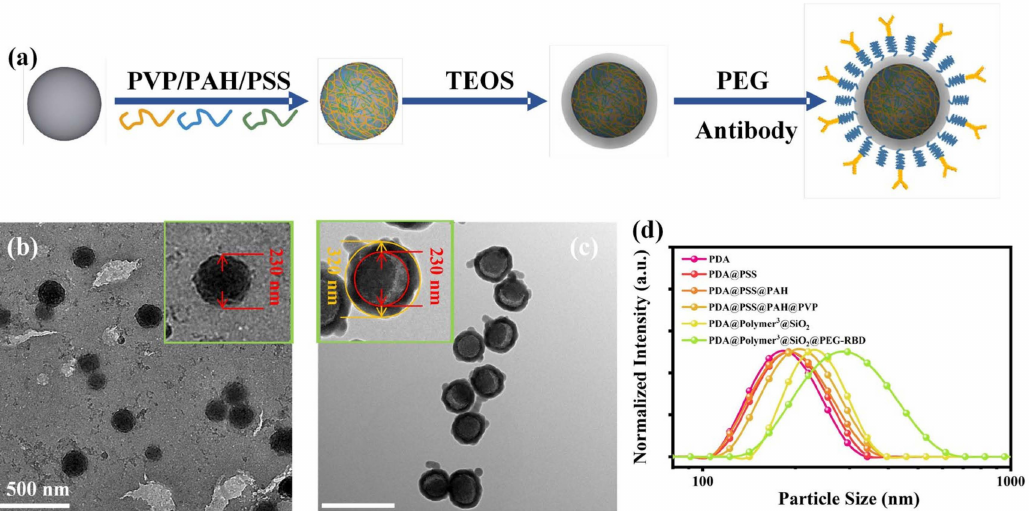
Figure 2. Synthesis and characterization of PDA probes. ( a ) Modification process of PDA@SiO 2 @PEG- Ab probes. TEM images of PDA ( b ) before and ( c ) after surface modifications. ( d ) Dynamic Light Scattering of PDA, PDA@Polymer 3 , PDA@Polymer 3 @SiO 2 , and PDA@polymer 3 @SiO 2 @PEG-Ab